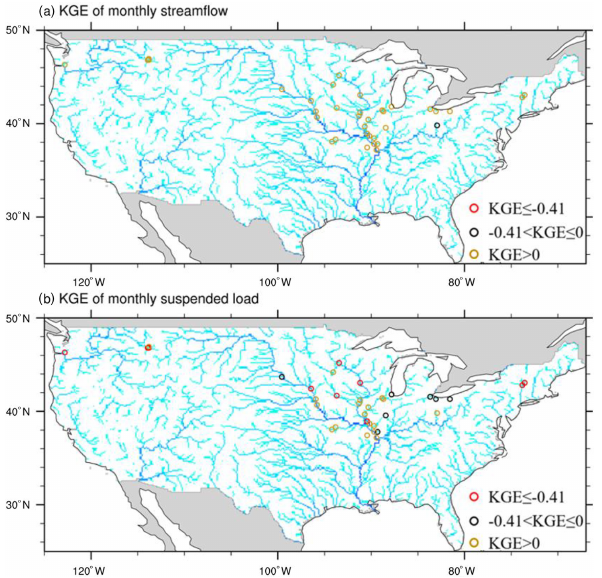
Figure 6. Evaluation of simulated monthly streamflow and sus- pended sediment at the selected USGS stations in 1990–2012. The river network is displayed as a background in terms of the accu- mulated upstream drainage areas at each grid (in different tones of blue).